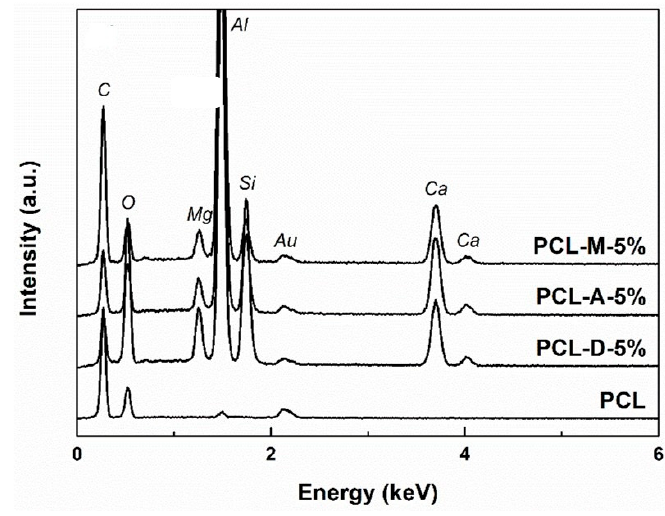
Figure 3. EDX spectra of the electrospun samples with 5% powder loading.